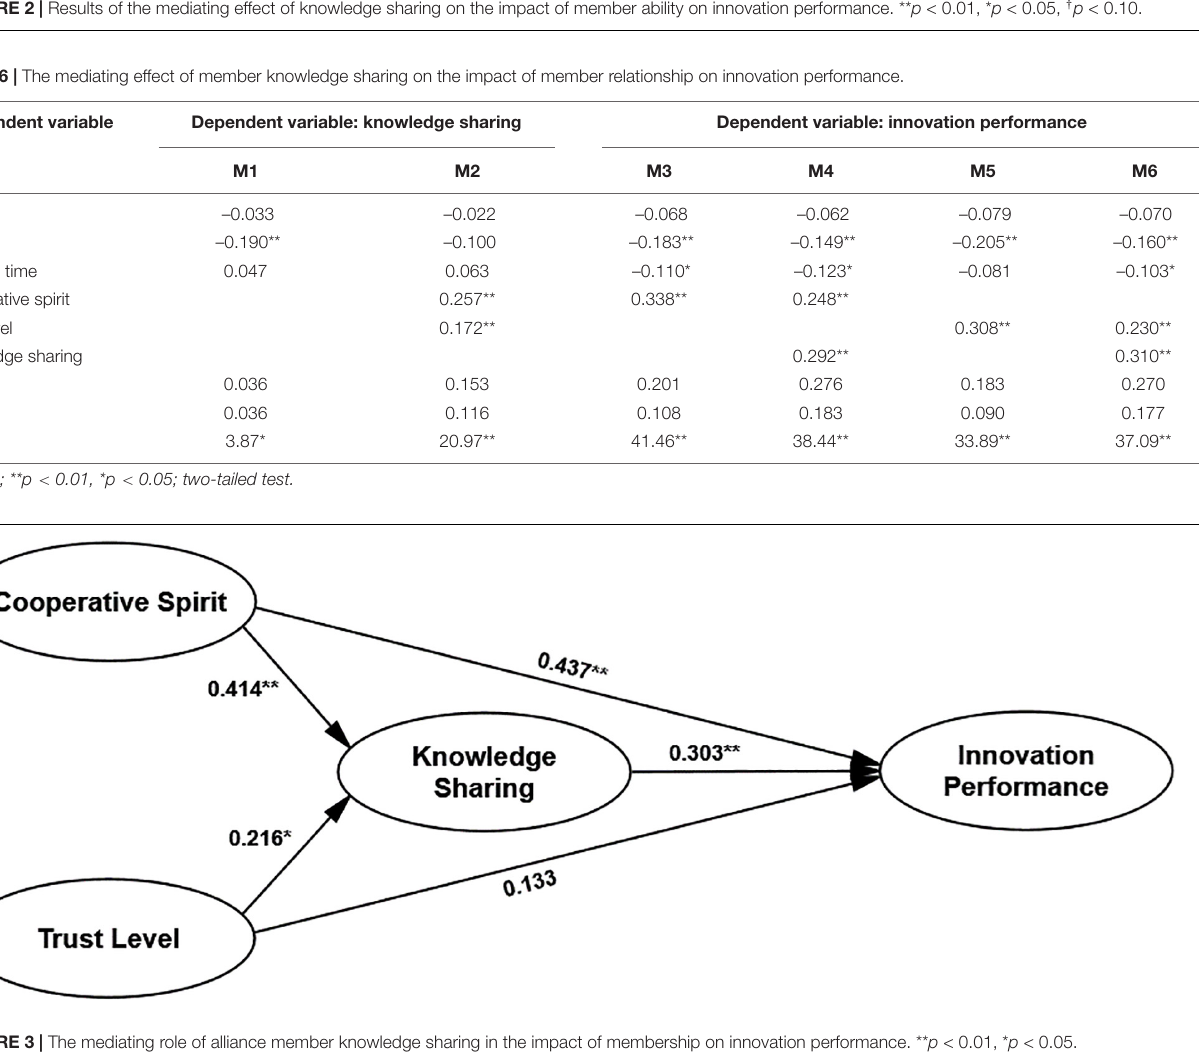
Frontiers in Psychology |